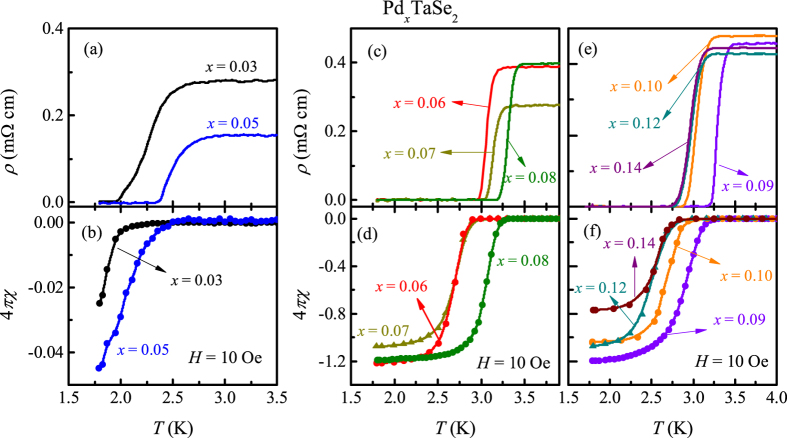
Low temperature behavior of zero-field resistivity ρ (a) for x = 0.03 and 0.05, (c) for 0.06 ≤ x ≤ 0.08, and (e) for x = 0.09, 0.10, 0.12 and 0.14. Temperature dependence of zero-field cooled susceptibility indicating the superconducting volume fraction (−4πχ) measured at H = 10 Oe (b) for x = 0.03 and 0.05, (d) for 0.06 ≤ x ≤ 0.08, and (f) for x = 0.09, 0.10, 0.12 and 0.14.